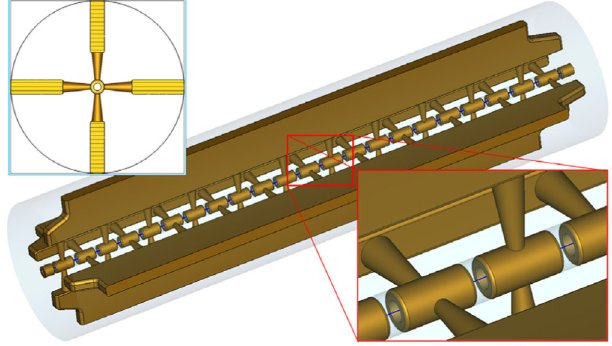
FIG. 26. Surface-current-magnitude distribution inside the CH tank for 20-MeV protons. The outer wall is